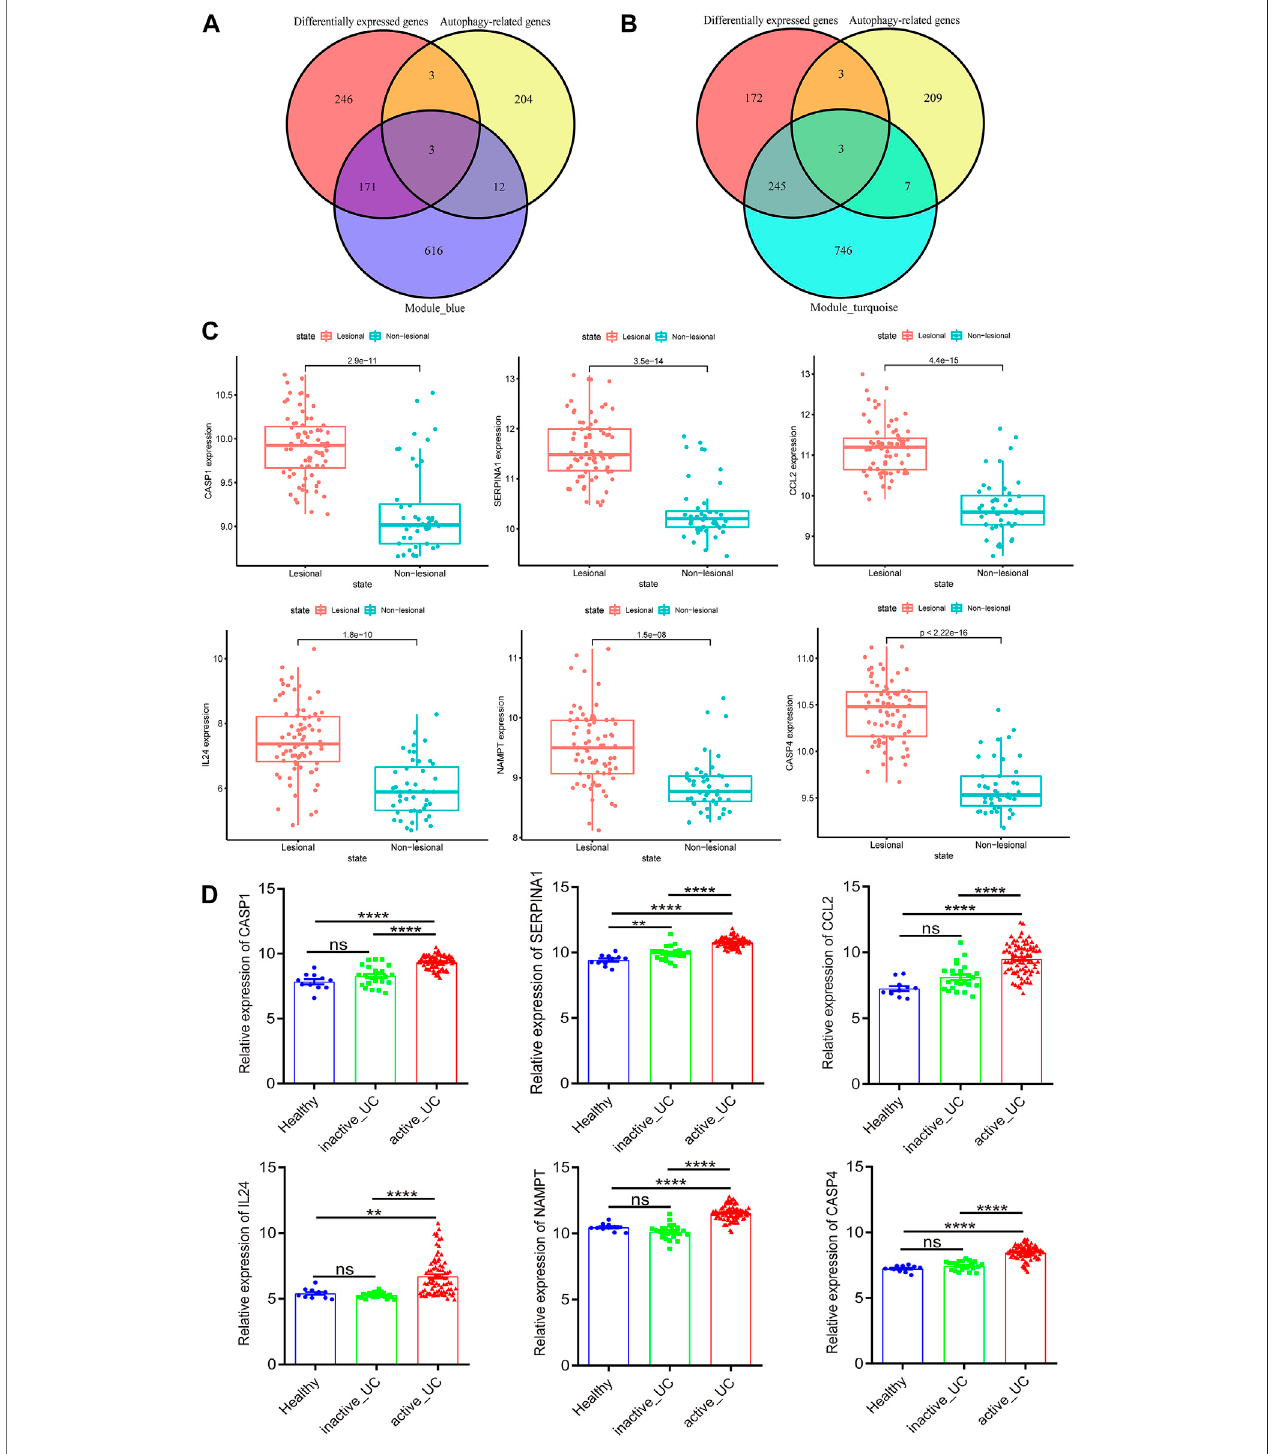
FIGURE4| Identi fi cationandveri fi cationofautophagy-relatedhubgenes. (A) Venndiagramshowstheoverlappinggenesbetweendifferentiallyexpressedgenes, autophagy-related genes and the genes of blue module. (B) Venn diagram shows the overlapping genes between differentially expressed genes, autophagy-related genesandthegenesofturquoisemodule. (C) TheexpressionofCASP1,SERPINA1,CCL2,IL24,NAMPT,andCASP4inthelesionalandnon-lesionalintestinalmucosa of active UC patients in GSE107499. (D) The expression of CASP1, SERPINA1, CCL2, IL24, NAMPT, and CASP4 in the intestinal mucosa of healthy controls, inactive and active UC patients in GSE59071. UC, ulcerative colitis. * p < 0.05, ** p < 0.01, *** p < 0.001, **** p < 0.0001, ns, not statistically signi fi cant.